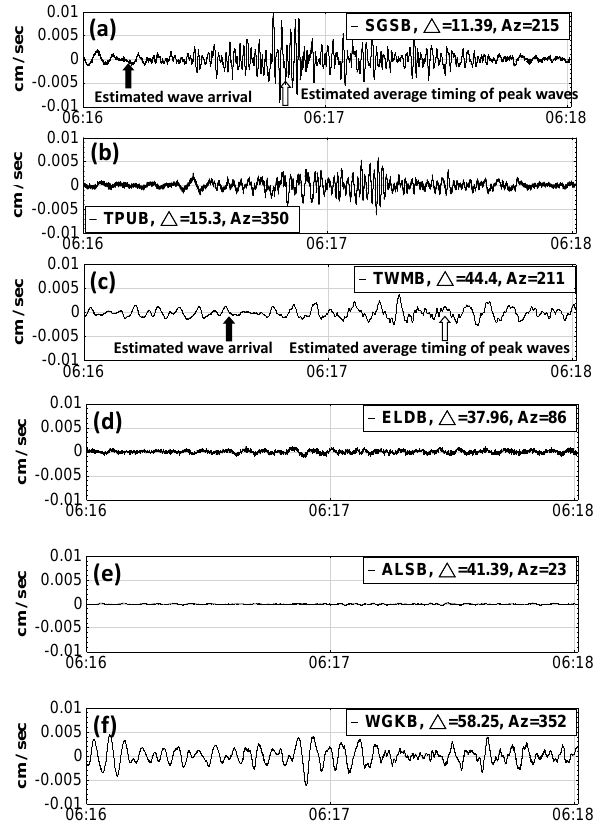
Original vertical velocity waveform of TWMB (Chishan)